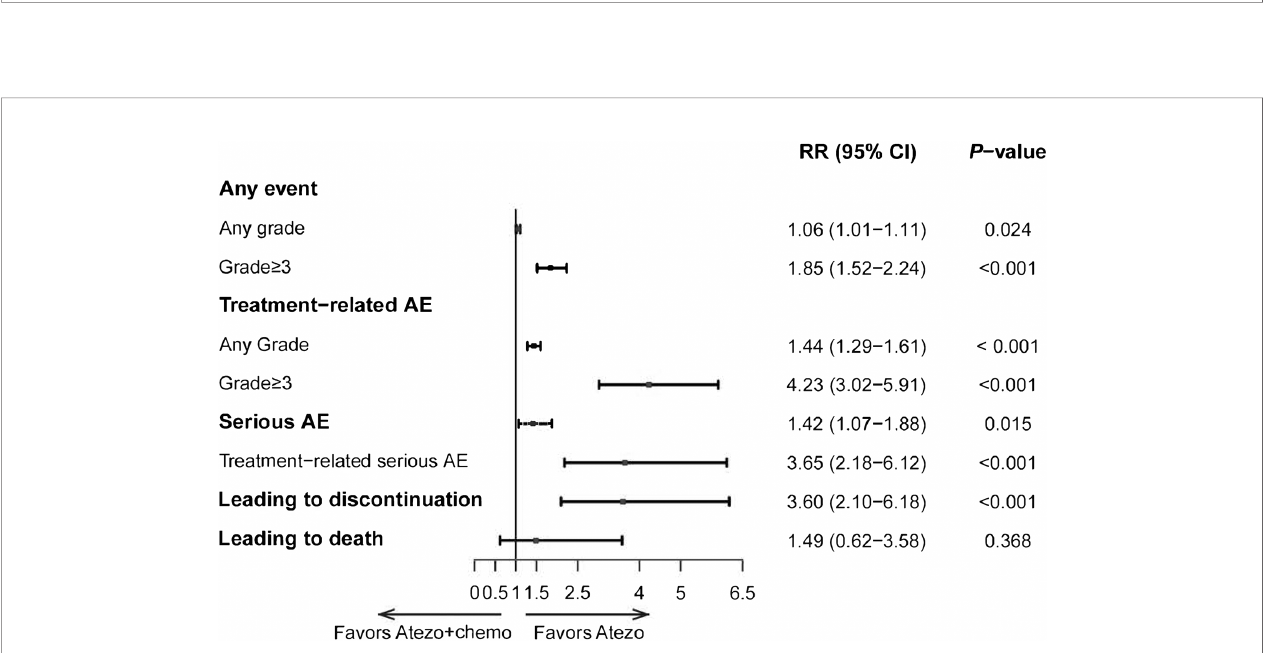
FIGURE 3 | Indirect comparisons of safety between Atezolizumab (Atezo) plus chemotherapy versus Atezolizumab for patients. The forest plot showed RRs for TRAEs between Atezo plus chemotherapy versus Atezo alone. The horizontal line crossing the square represents the 95% con fi dence interval (CI). The diamonds represent the estimated overall effect, based on the